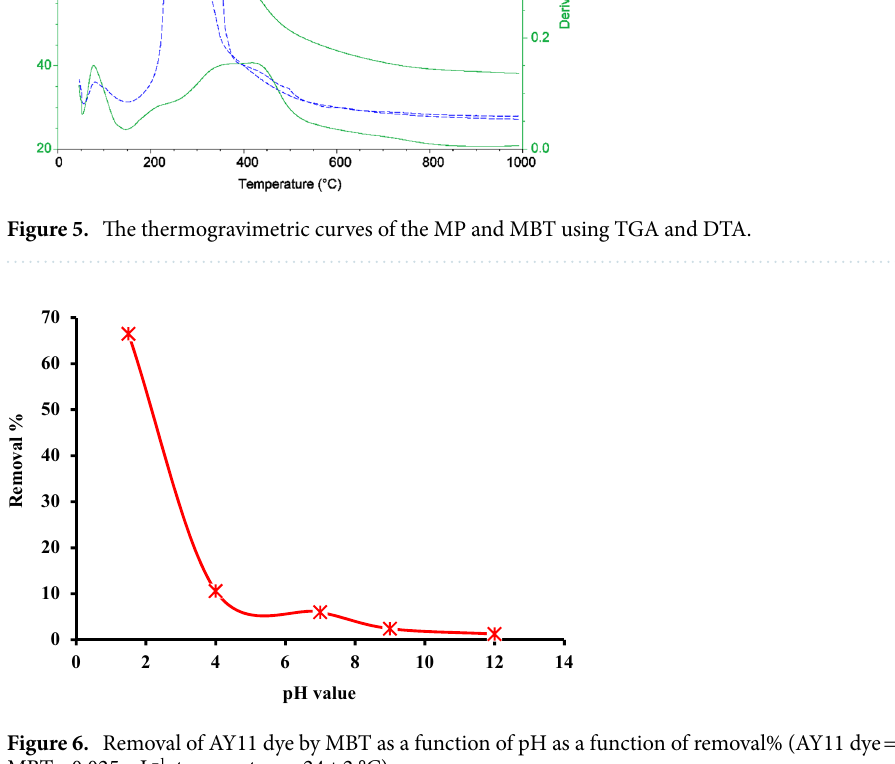
Figure 6. Removal of AY11 dye by MBT as a function of pH as a function of removal% (AY11 dye = 75 mg L –1 , MBT = 0.025 g L –1 , temperature = 24 ± 2